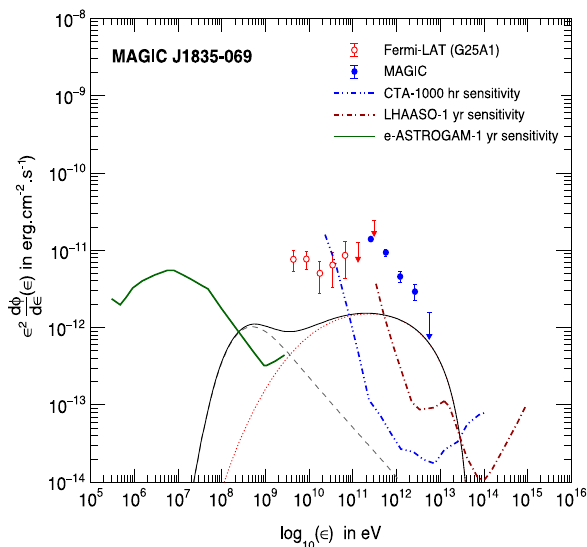
Fig. 5 Same as in left-hand panel Fig. 4 but from MAGIC J1835-069 which is investigated to be a molecular cloud associated with